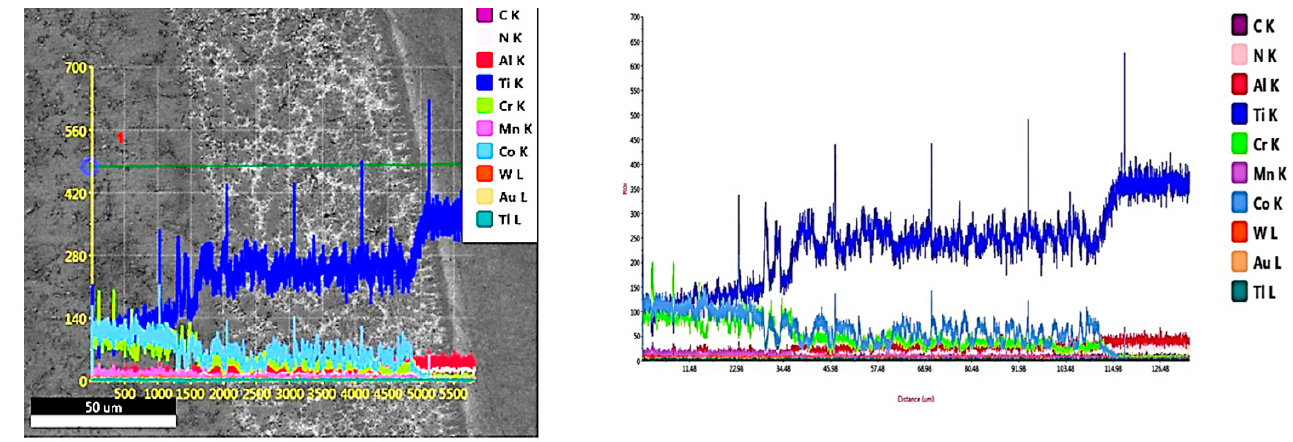
Figure 7. EDAX line scan along the cross-section of MMC layer of sample 1.